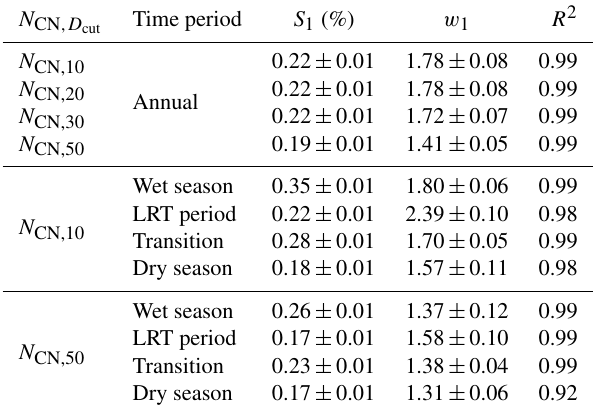
Table 7. Erf fit parameters describing CCN efficiency spectra N CCN ( S)/N CN ,D vs. S as model input data (compare to Figs. 13 cut and 14). Fit parameters are provided for (i) annually averaged ef- ficiency spectra with five different aerosol number reference con- and (ii) resolved by seasons for N CN,10 and centrations N CN ,D cut N CN,50